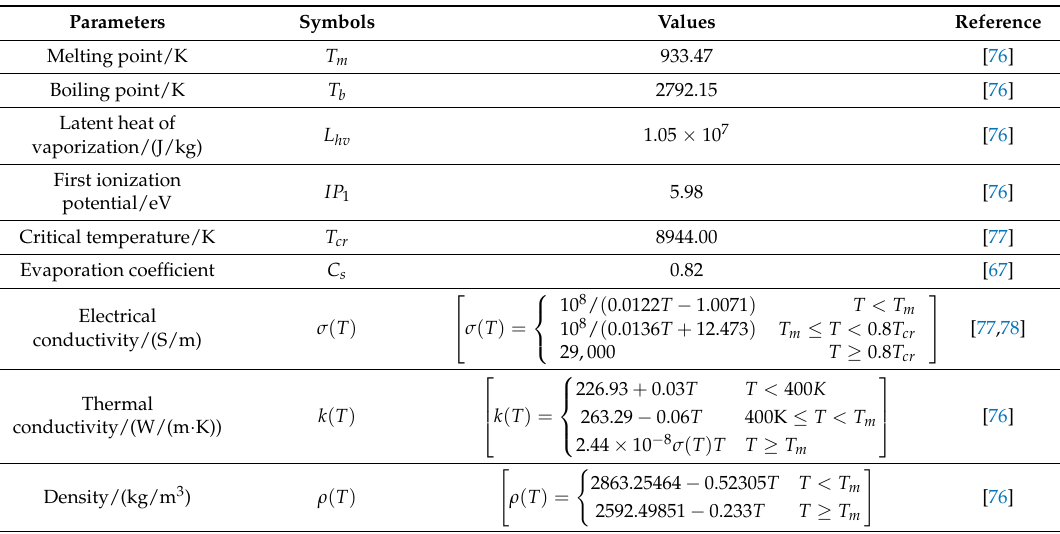
Table 1. Parameters of aluminum (Al) used in the model.